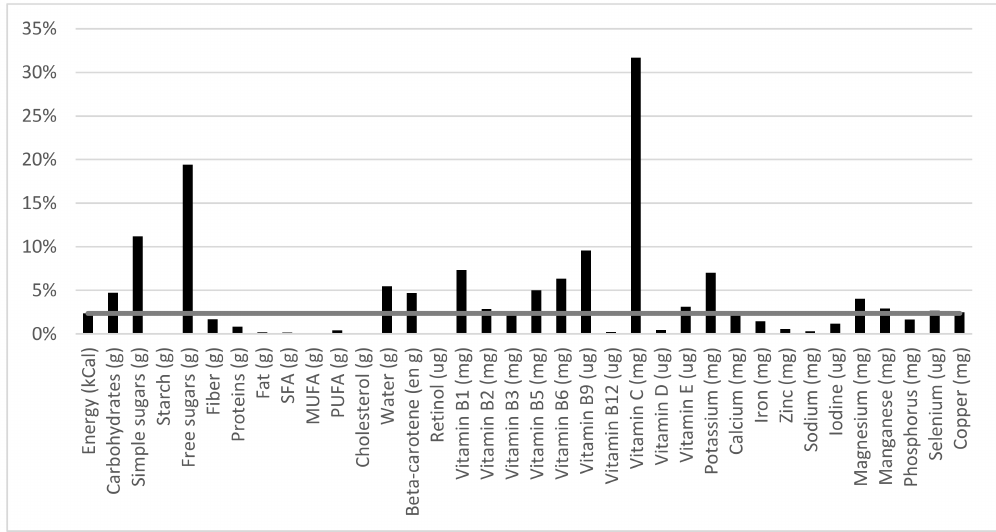
Figure 2. Contribution (%) of FJ to nutritional intakes in FJ consumers. The horizontal gray line projects the level of energy (2%) contributed by